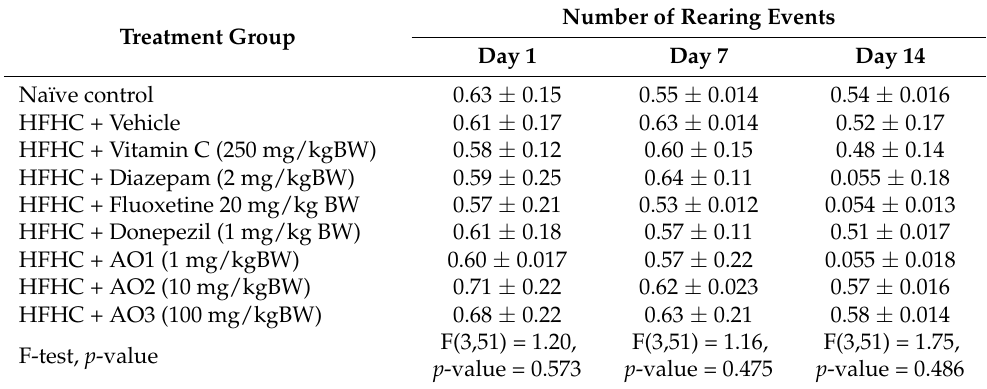
Table 3. Effect of the functional ingredient containing cashew leaf extract and cashew apple pomace- derived dietary fiber (AO) on number of rearing events. Data are presented as mean ± SEM) n =